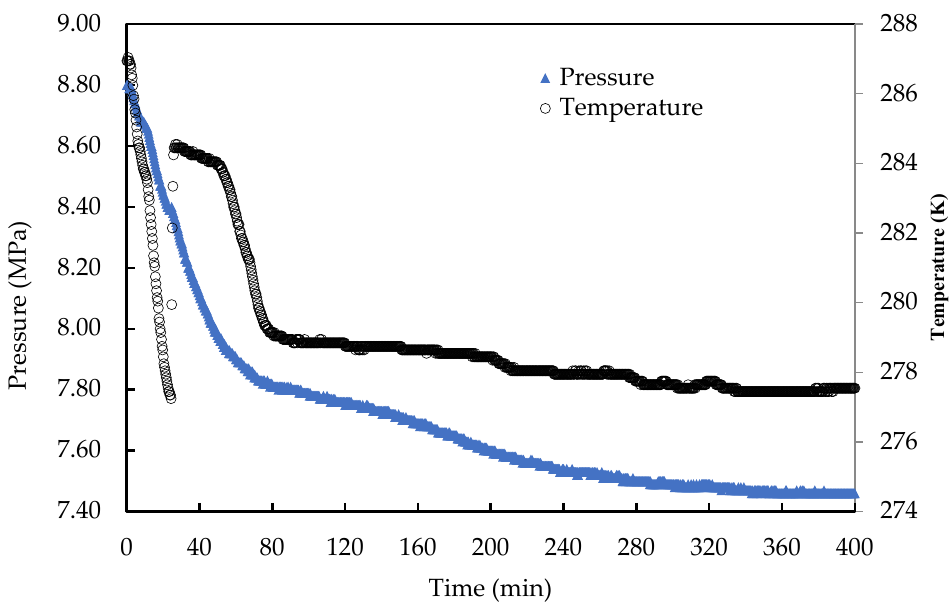
Figure 4. A Typical profile of CH 4 hydrate formation profile in the presence of non-ionic surfactant in multiphase system.